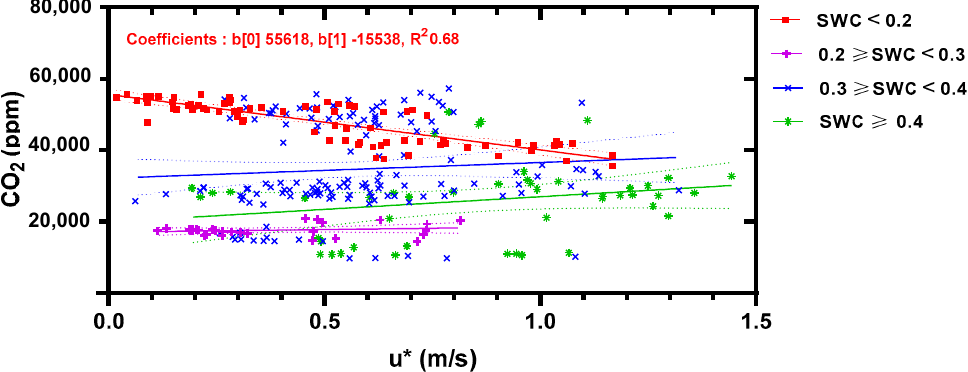
Figure 9. The relationship between hourly CO 2 molar fraction ( χ c) at 6m depth and friction velocity (u*) above the canopy for different levels of SWC.